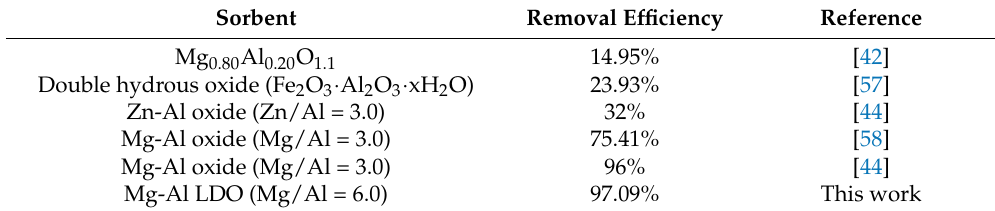
Table 6. Comparative study of the removal efficiency of LDO against other reported sorbents for Cl − .